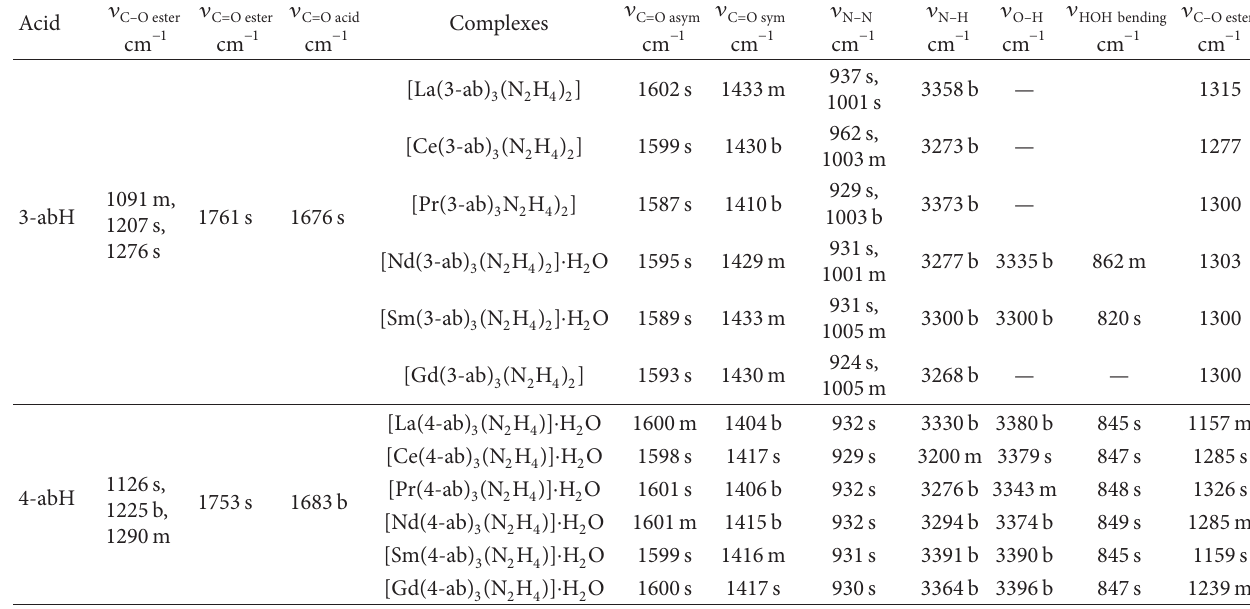
T 3: IR data of lanthanide complexes of 3-abH and 4-abH (4-abH: 4-acetoxy benzoic acid, 3-abH: 3-acetoxy benzoic